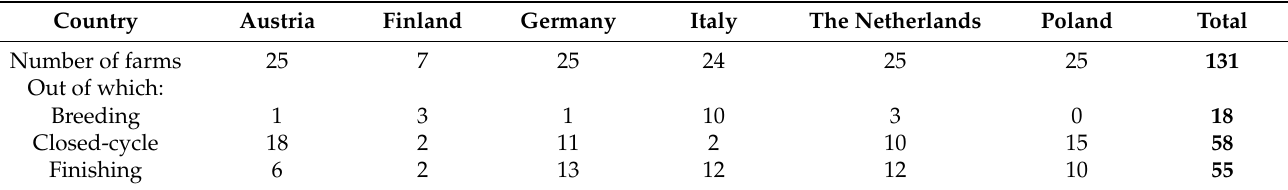
Table 3. Number of farms in the sample per country and farm